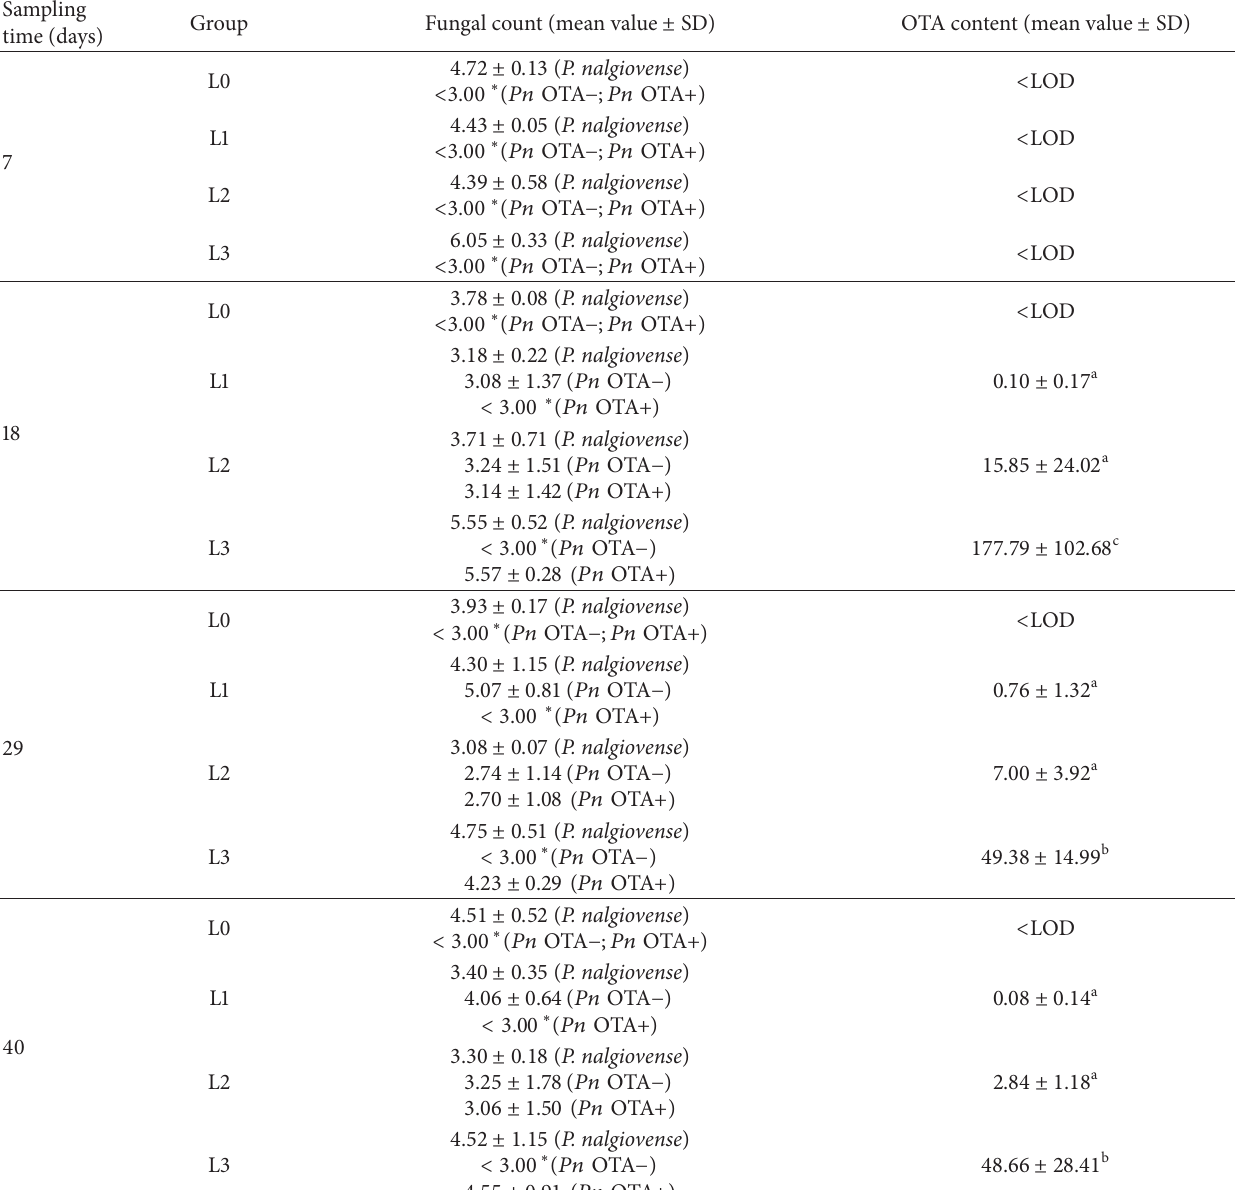
Table 3: Fungal counts (LogCFU/cm 2 ) and OTA content ( 𝜇 g/kg) in ripened salami for control (L0) and treated groups (L1 to L3) at different sampling